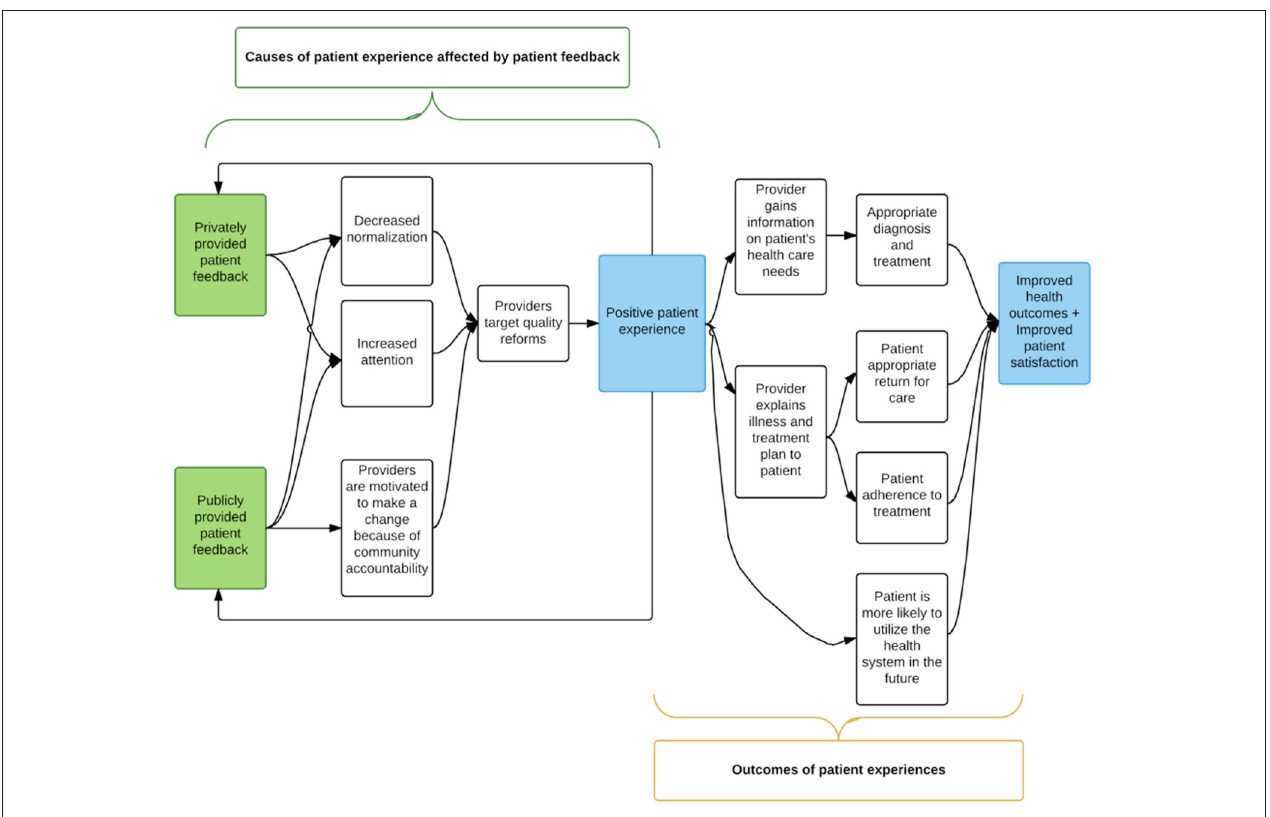
FIGURE 1 | Theory of change for the BASI